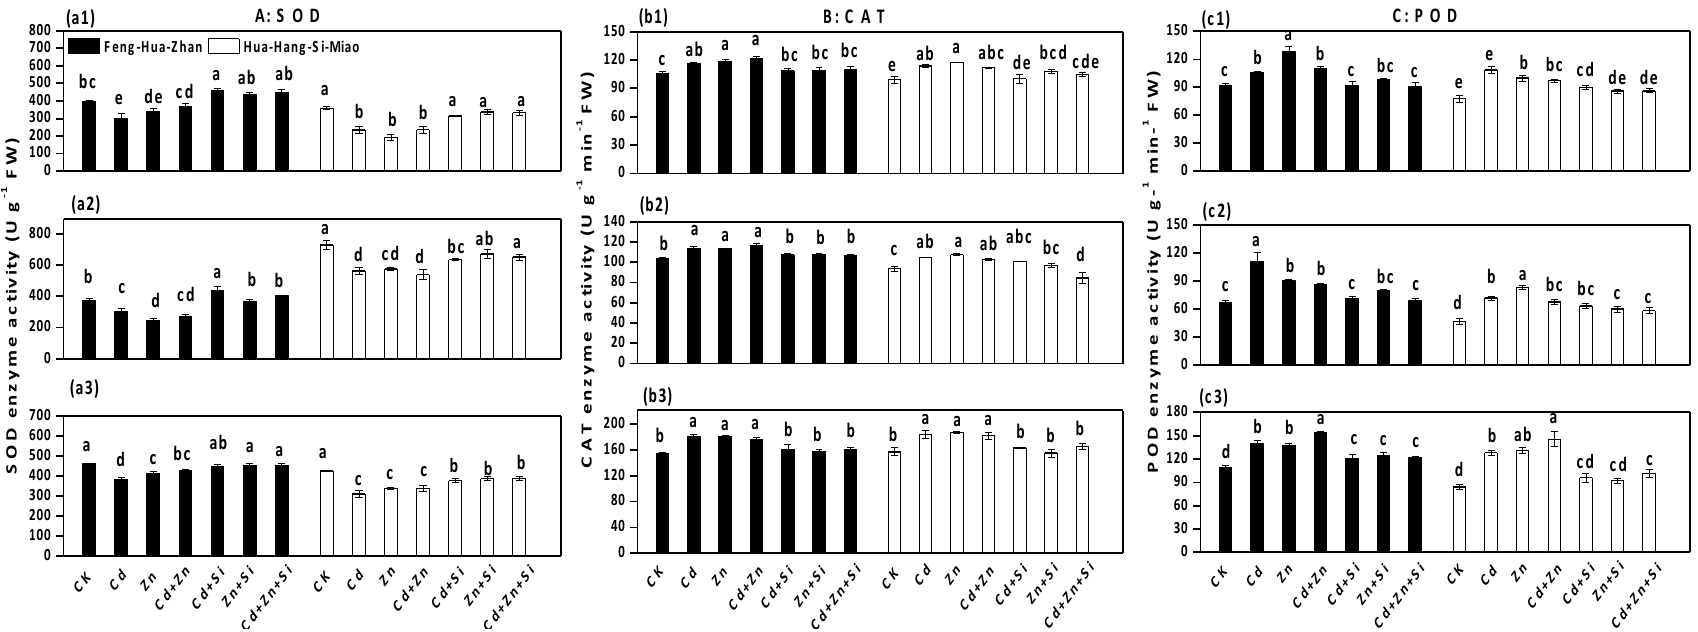
Figure+6. "The"effect"of"Si"on"antioxidant"enzyme"activity"in"two"rice"cultivars"in"different"growth"stages:"( a1 ),"( b1 )"and"( c1 )"seedling"stage;"( a2 ),"( b2 )"and"( c2 )"tillering"stage;"( a3 ),"( b3 )" Figure 6. The effect of Si on antioxidant enzyme activity in two rice cultivars in different growth stages: ( a1 ), ( b1 ) and ( c1 ) seedling stage; ( a2 ), ( b2 ) and ( c2 ) tillering and"( c3 )"ripening"stage."Error"bars"indicate"standard"deviations"( n "="4)."Bars"with"different"letters"are"significantly"different"( p% <"0.05)"according"to"Duncan’s"MRT." stage; ( a3 ), ( b3 ) and ( c3 ) ripening stage. Error bars indicate standard deviations ( n = 4). Bars with different letters are significantly different ( p < 0.05) according to Duncan’s